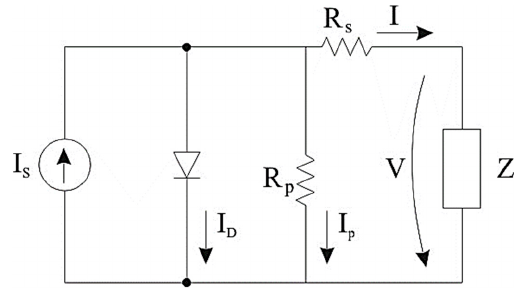
Figure 6. Equivalent electrical circuit of a PV cell.